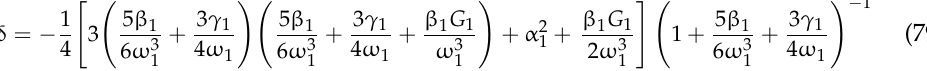
0 given by Equation (61) on the domain [